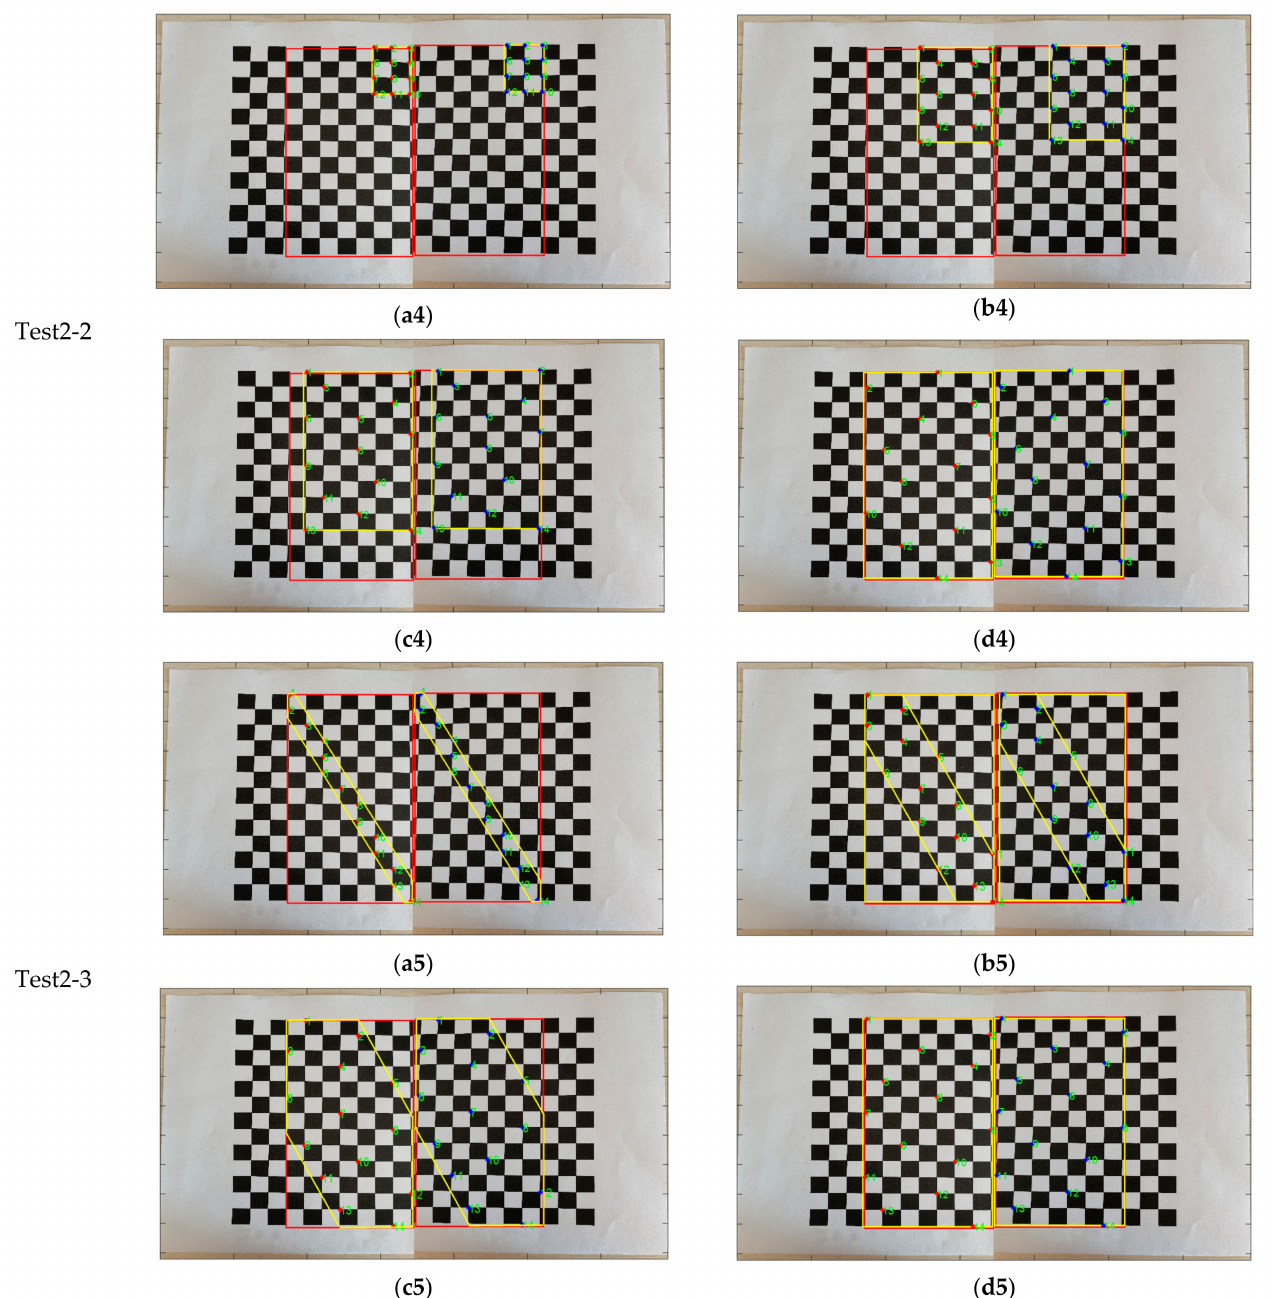
Figure 4. Data source of the simulation scene. The red rectangle indicates the overlapping region, and the yellow rectangle indicates the region where known matching points are located. There are 112 pairs in ( a1 ), 56 pairs in ( b1 ), 28 pairs in ( c1 ), and 14 pairs in ( d1 ). There are about 16 pairs of matching points in the center of the overlapping region in ( a2 ), in the center-right overlapping region in ( b2 ), and gathered toward the upper-right corner of the overlapping region from ( a2 ), ( c2 ) to ( d2 ). There are about 14 pairs of known matching points extending from the center to the entire overlapping region in ( a3 – d3 ), extending from the upper-right corner to the entire overlapping region in ( a4 – d4 ), and extending linearly to the entire overlapping region in ( a5 – d5